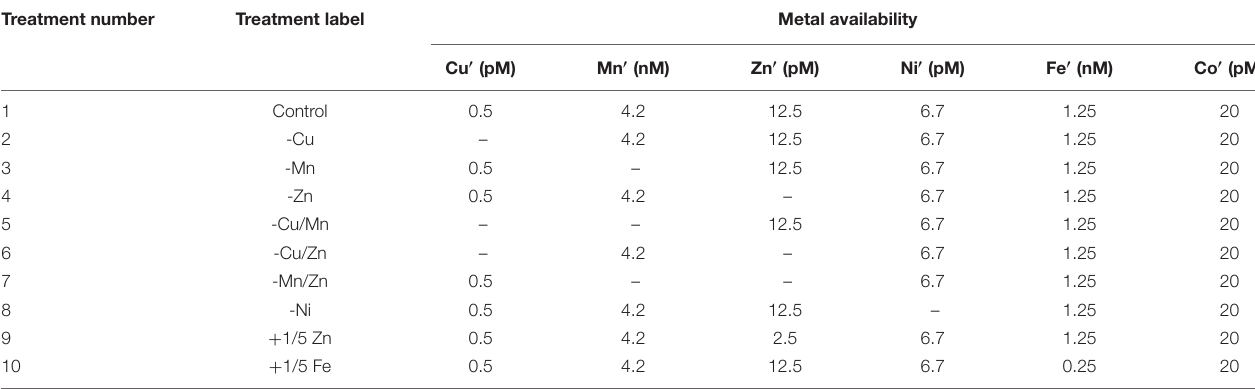
TABLE 2 | Trace metal concentrations in batch cultures to investigate the interactive effects of Cu, Zn, and Mn on S. kawagutii growth. Treatment number Treatment